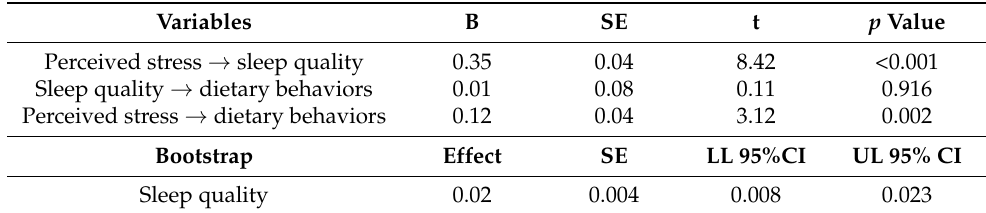
Table 6. Model 1 mediation